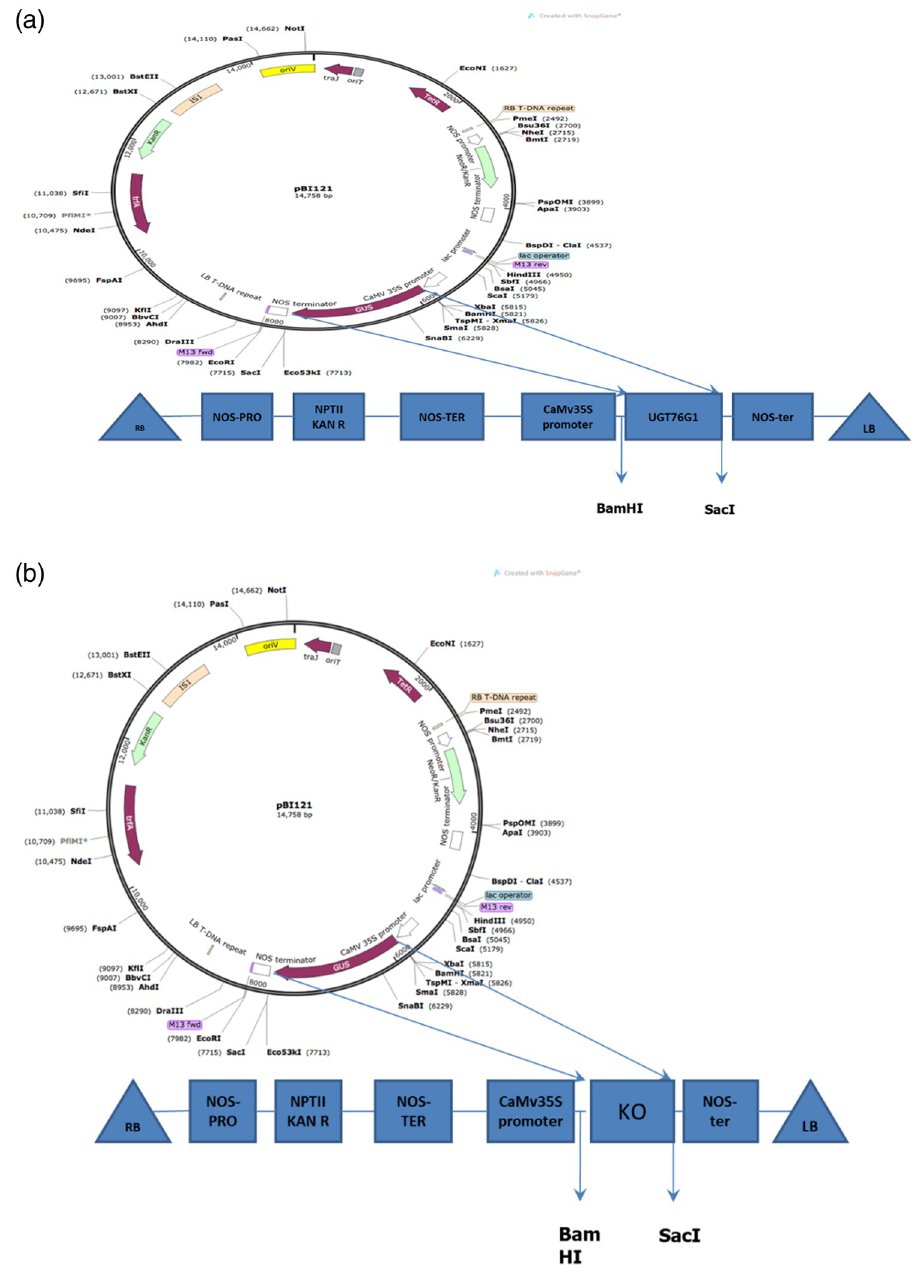
Fig 1. Binary vectors containing A: UGT76G1 and B: KO gene inserted in place of gus gene. GFP as reporter gene was used as control (Fig 1a and 1b). The transformed leaves were con- firmed by visualizing the leaves under Leica TCS SP5 confocal microscope equipped with long lasting solid state lasers (Leica Microsystems, Germany). Expression of GFP was visible after 24h of transformation, which increased with time until reached a plateau phase at fourth day (Fig 2a and 2b) there, was no florescence in control (Fig 2c). The SrKO and SrUGT76G1 cDNA were cloned separately in pBI121 plasmids. These plasmids were then mobilized in A .